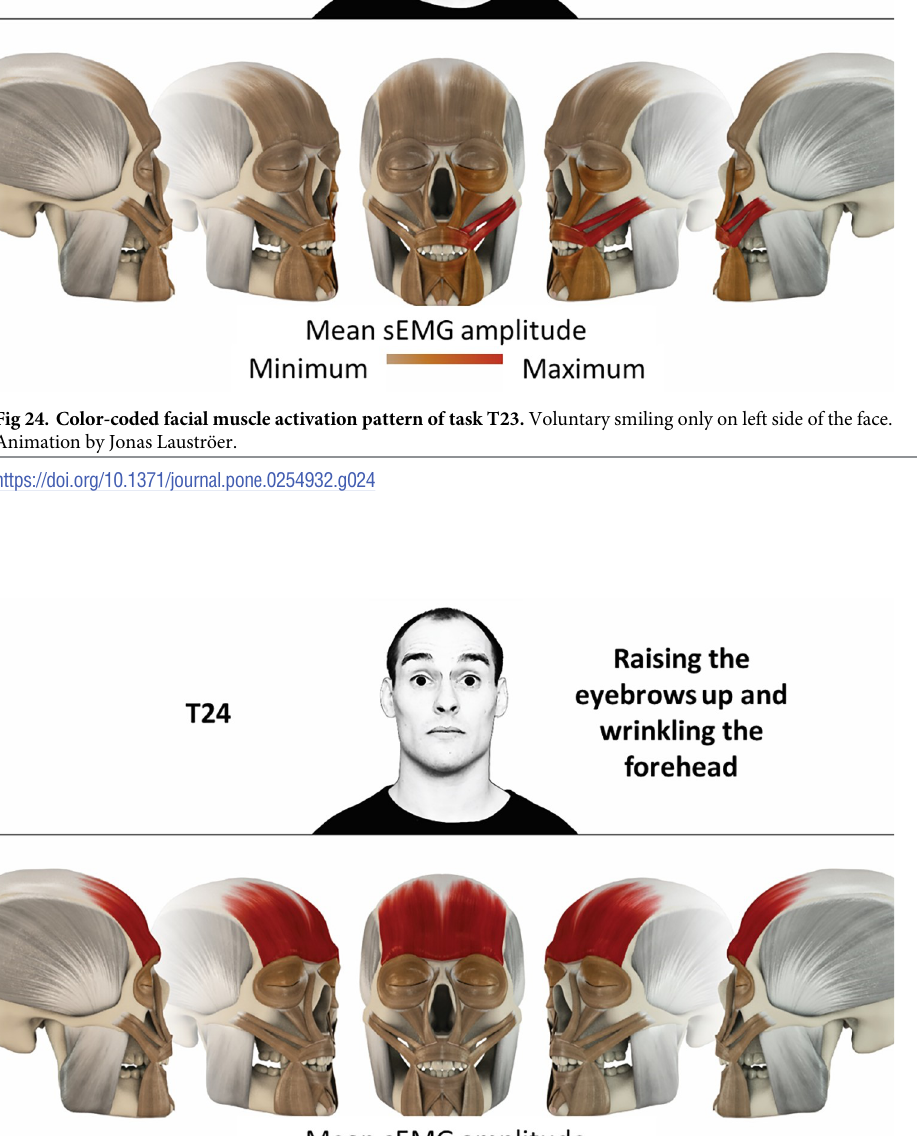
PLOS ONE | https://doi.org/10.1371/journal.pone.0254932 July 19,